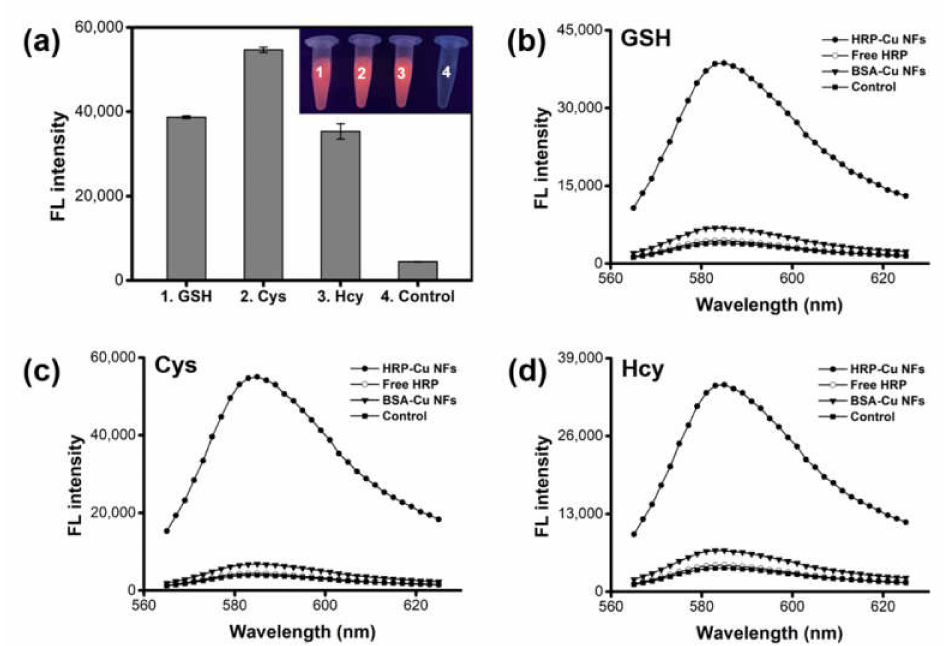
Figure 2. Demonstration for the biothiol detecting activity of HRP-Cu NFs. ( a ) Fluorescence intensities and the corresponding images from the HRP-Cu NFs-based cascade reaction toward GSH, Cys, and Hcy. Control includes HRP-Cu NFs and AUR without biothiols. Fluorescence spectra for the detection of ( b ) GSH, ( c ) Cys, and ( d ) Hcy. The concentration of biothiols was 1 µ